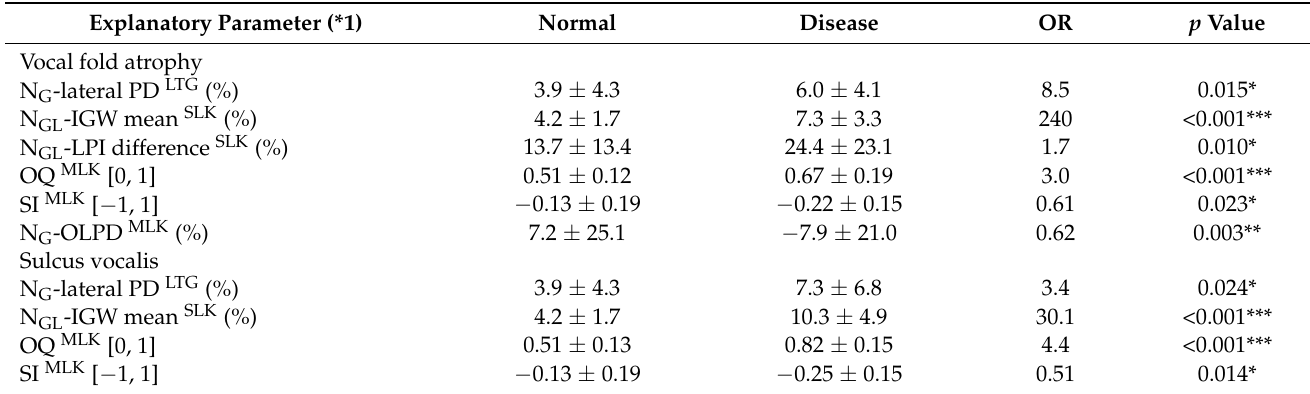
Table 9. Key parameters of vocal fold atrophy and sulcus vocalis.